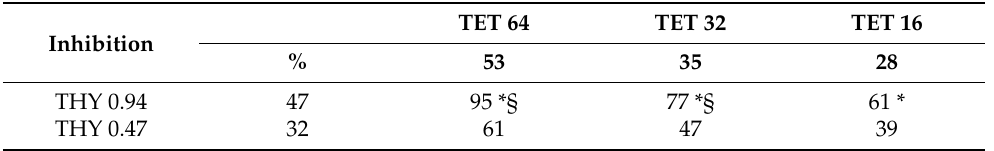
Table 2. Percentage inhibition of the two ETEC strains resistant to colistin in the presence of combina- tions of colistin (COL, mg/L) and thymol (THY, mM). COL 16 COL 8 COL 4 Inhibition % 35 10 7 THY 0.94 15 100 *§ 54 *§ 35 THY 0.47 8 100 *§ 47 *§ 38